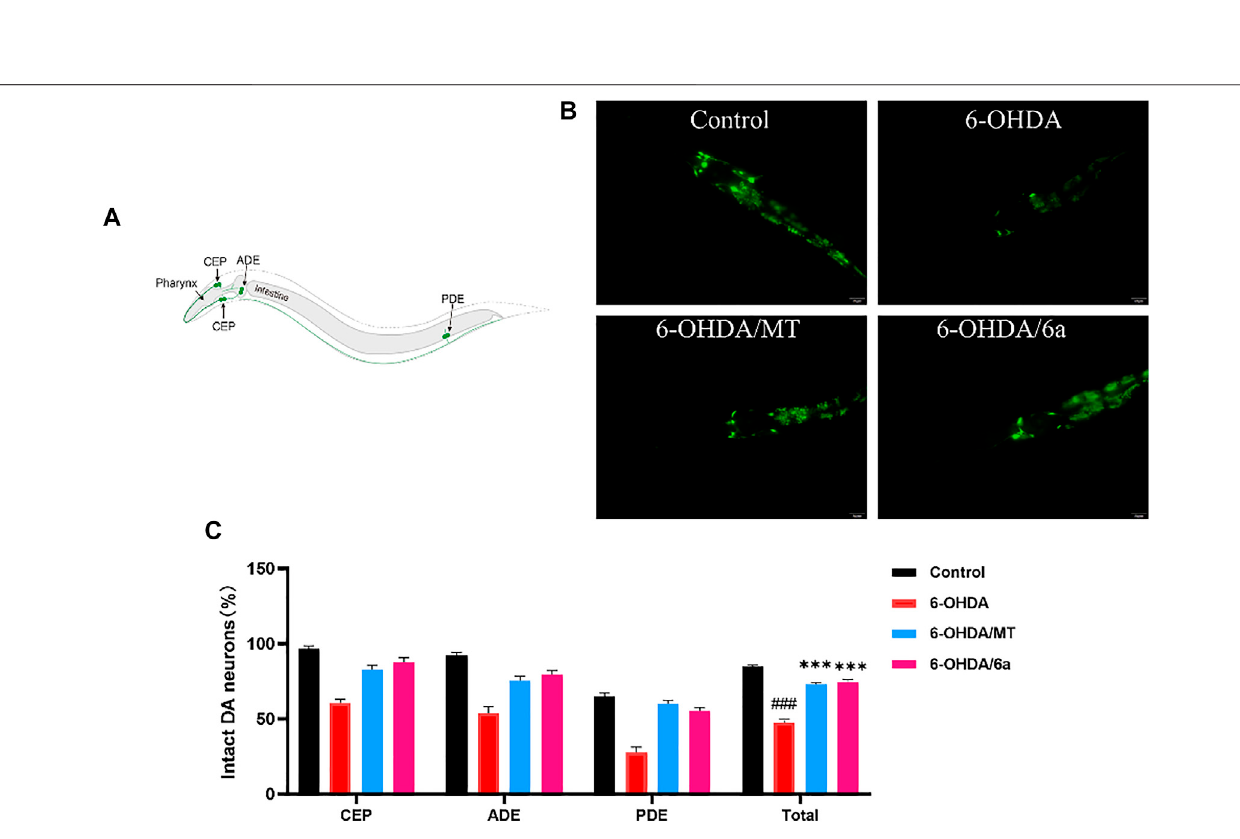
Frontiers in Chemistry |